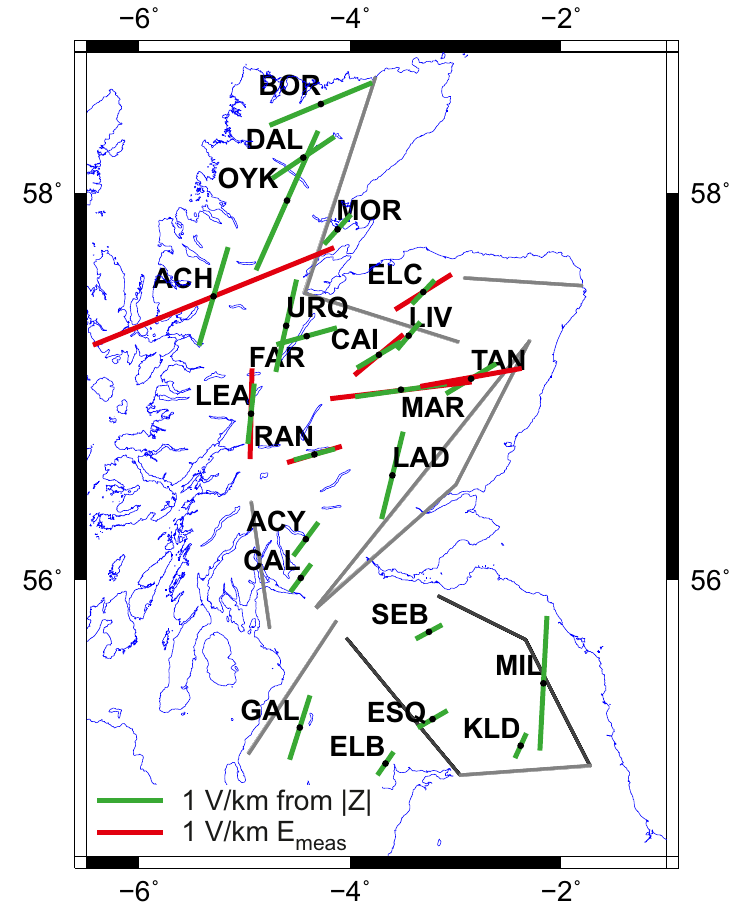
Fig. 10. Vector representation of the maximum peak-to-peak, September 2017 storm-time, electric fi eld magnitudes at 01:25 UT on 8th September 2017. There is an inherent 90 (cid:3) ambiguity in these directions. However, they mostly do not correspond with the directions of coastlines. Light and dark grey lines are the longest (>50 km) 12 high-voltage – 275 kV and 400 kV, respectively – transmission lines in the region (Viljanen et al., 2013).